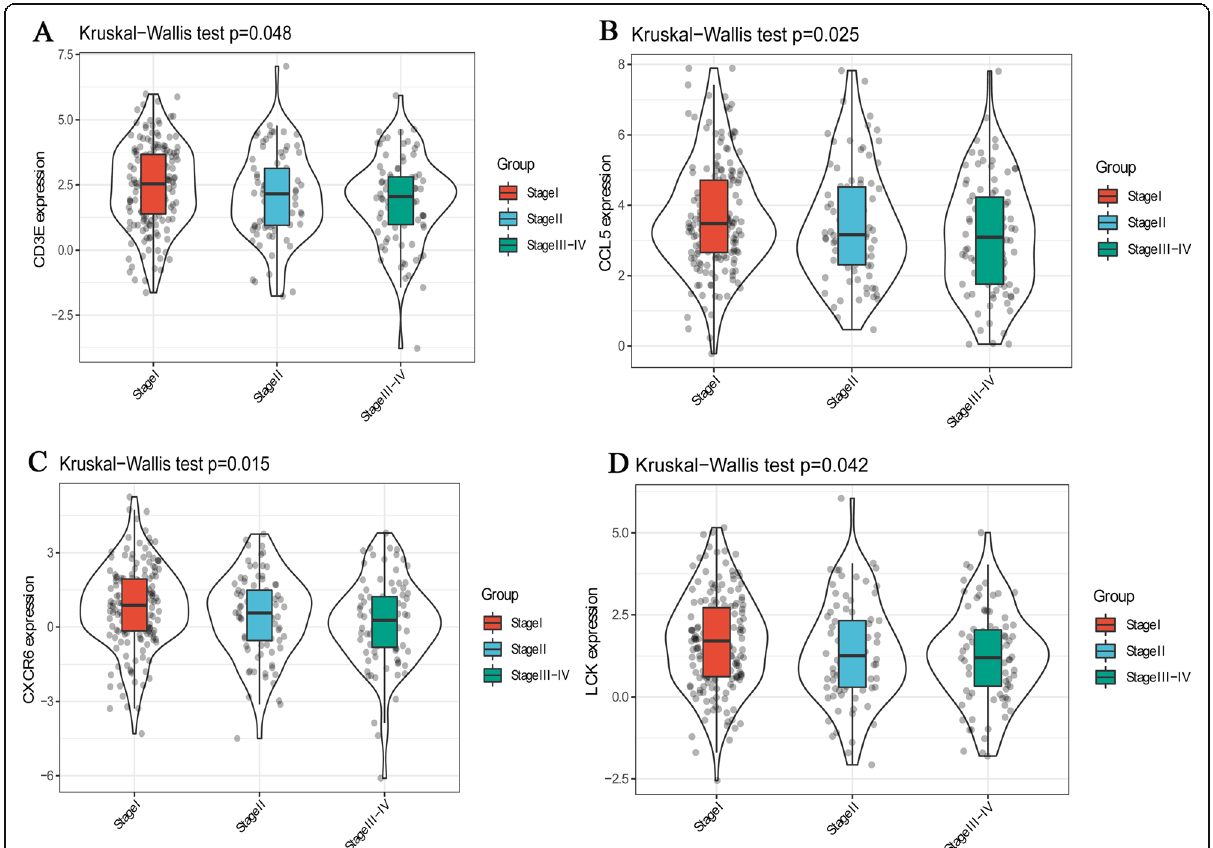
Fig. 9 Differential expression of CD3E ( A ), CCL5 ( B ), CXCR6 ( C ) and LCK ( D ) in different pathological stages. P < 0.05 was considered to indicate a statistically significant difference. A Kruskal-Wallis test was used to analyze the statistical significance among stage I, stage II and stage